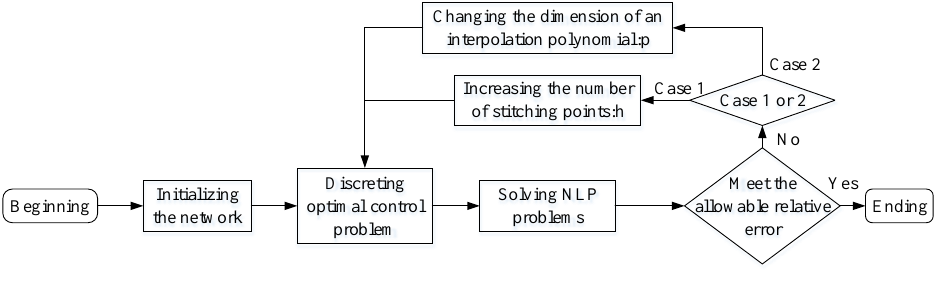
Figure 3. Adaptive pseudo-spectral calculation process.